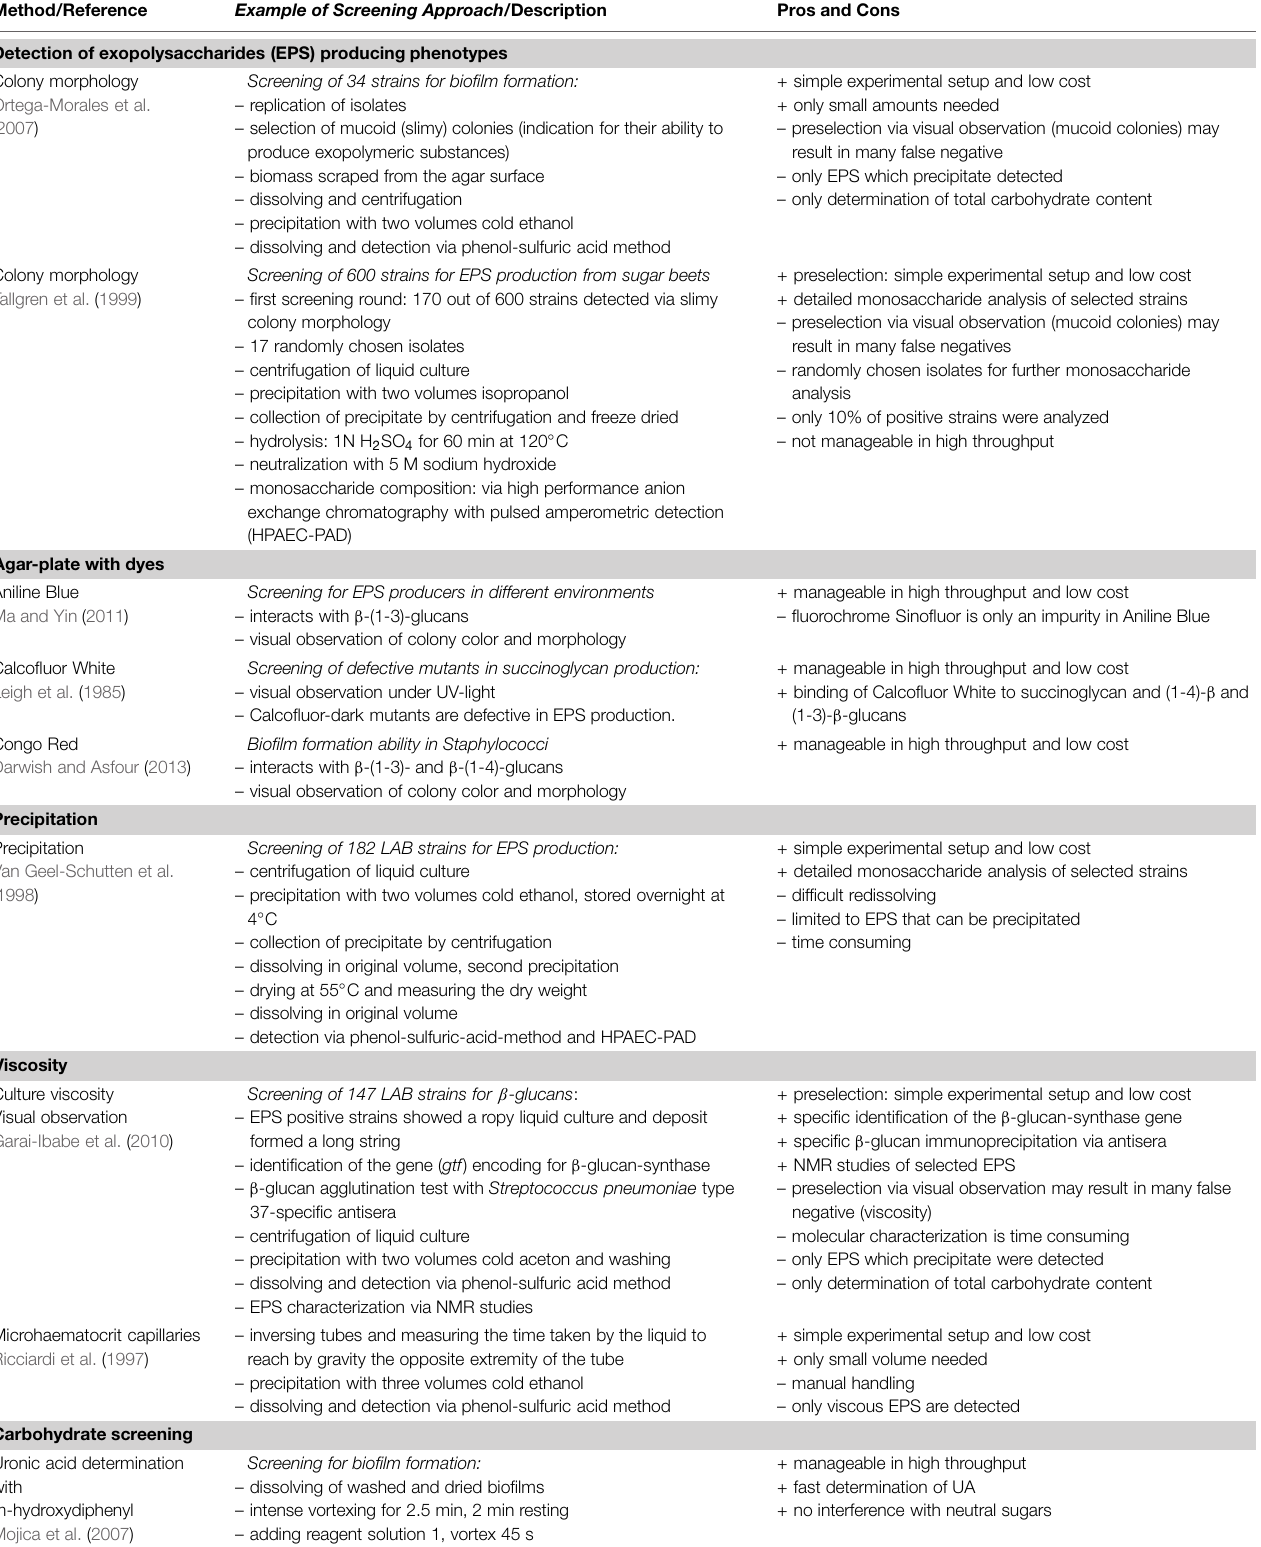
TABLE 1 | Overview and description of different screening approaches including benefits and